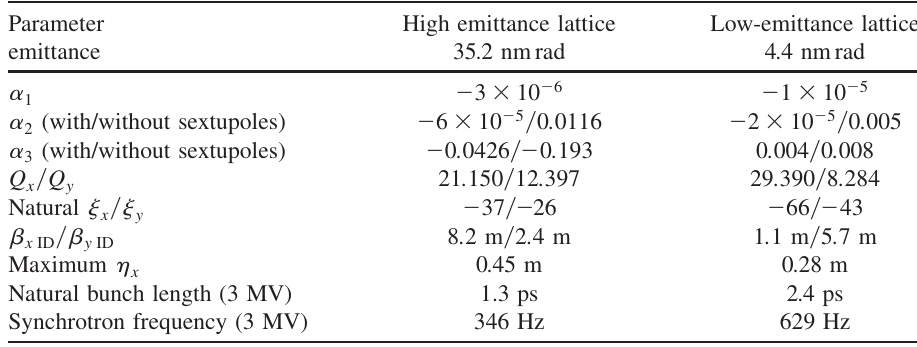
TABLE I. Main design parameters of the two low-alpha lattices.